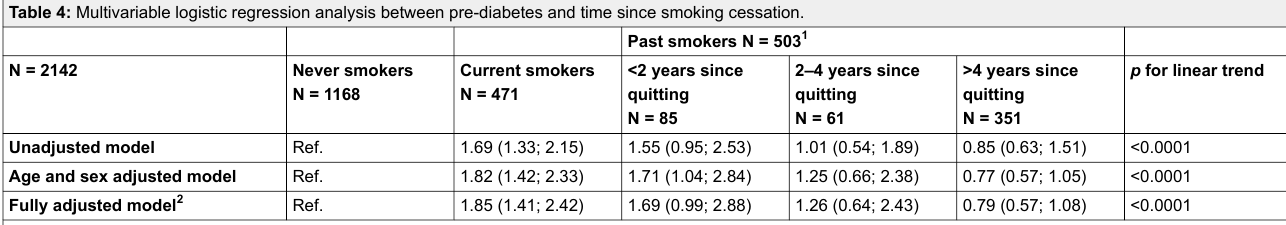
Table 4: Multivariable logistic regression analysis between pre-diabetes and time since smoking cessation.